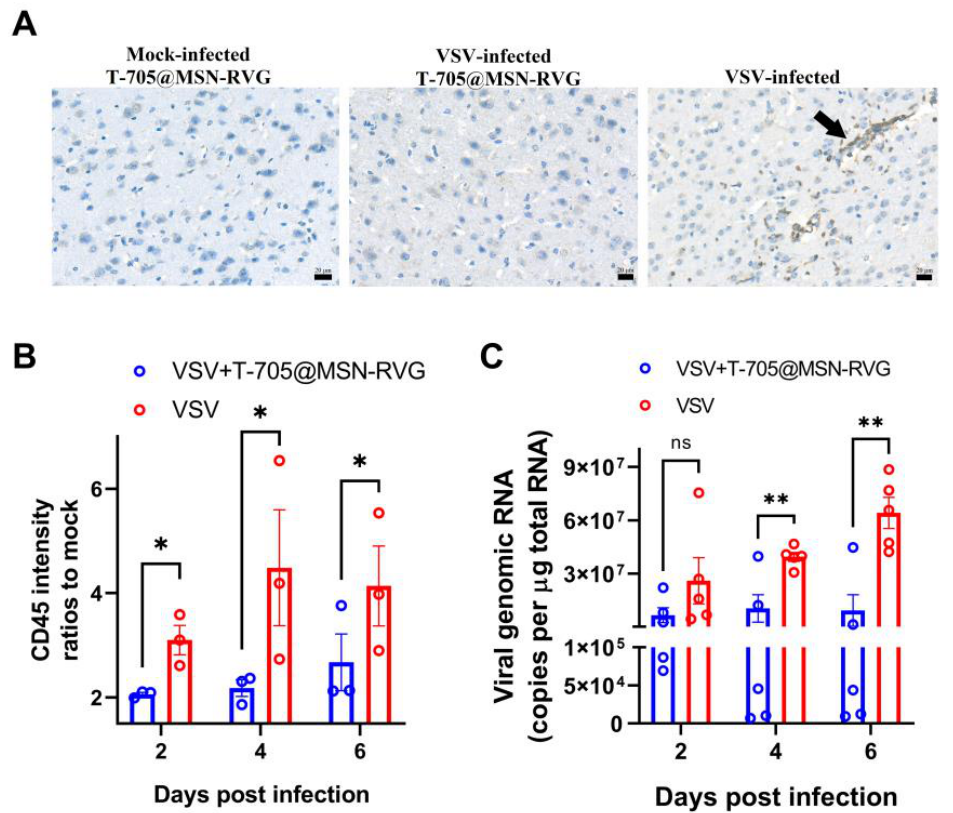
Figure 7. Changes in cell inflammation and viral load post treatment. Six-week-old Balb/c mice (VSV-GFP infected at 100 FFU) were inoculated with 25 µ L of T-705@MSN-RVG (2 mg/mL) via i.v. route. ( A ) CD45 positive cells in mouse brains were visualized in the mock-infected T-705@MSN-RVG-inoculated group, VSV-infected T-705@MSN-RVG therapy group, and VSV-infected virus control group. Scale bar 20 µ m. The black arrow indicates the CD45 positive cells with dark gray staining in the cells. ( B ) CD45 intensity ratios to mock and ( C ) viral genomic RNA (copies/ µ g total RNA) of the virus control group and VSV+T-705@MSN-RVG therapy group were analyzed at 2, 4, and 6 dpi. Statistical analysis of grouped comparisons was carried out by Student’s t -test (ns represents not significant, * p < 0.05; ** p < 0.01). The bar graph represents means ± SE.